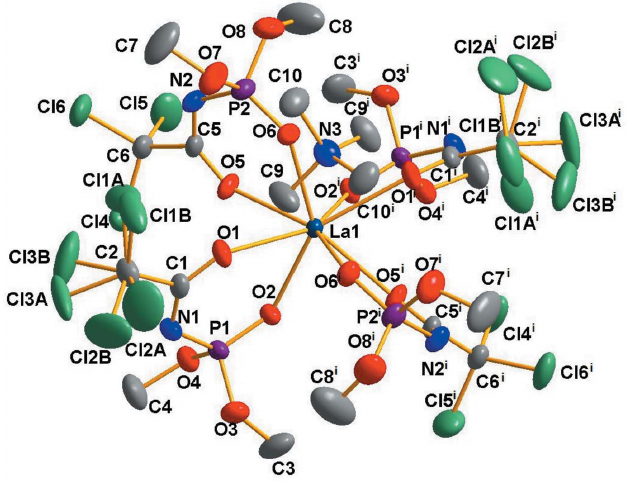
Figure 1 The molecular structure of the title compound with displacement ellipsoids drawn at the 25% probability level. Hydrogen atoms are omitted for clarity [Symmetry code: (i) (cid:3) x + 1